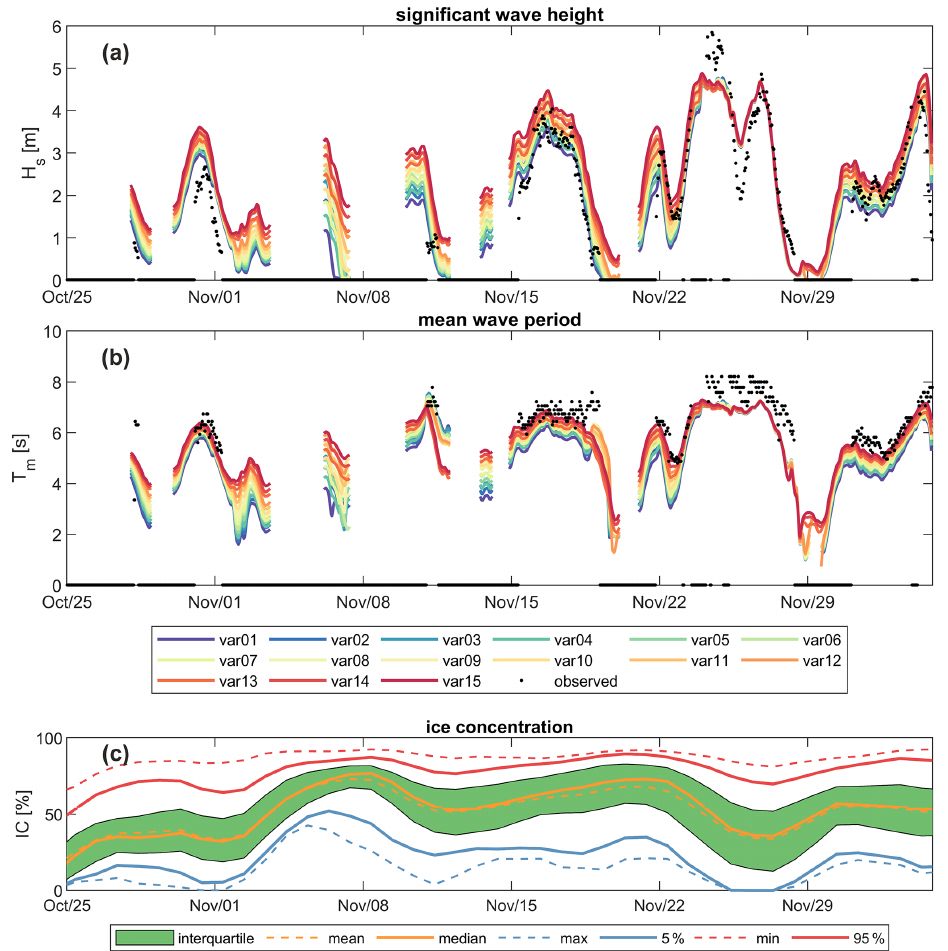
Figure 6. Wave height (a) and wave period (b) as observed (black dots) and modeled (colored lines) with the detailed intermediate domain using various combinations of empirical ice formulations (Table 3) for the observation period in 2007. Ice concentrations (IC; panel c ) are high across the domain. The different colors in panel (c) show the mean, 5%, 25%, 75%, and 95% exceedance probability. The interquartile range (IQ) is the area shaded green between the 25th and 75th